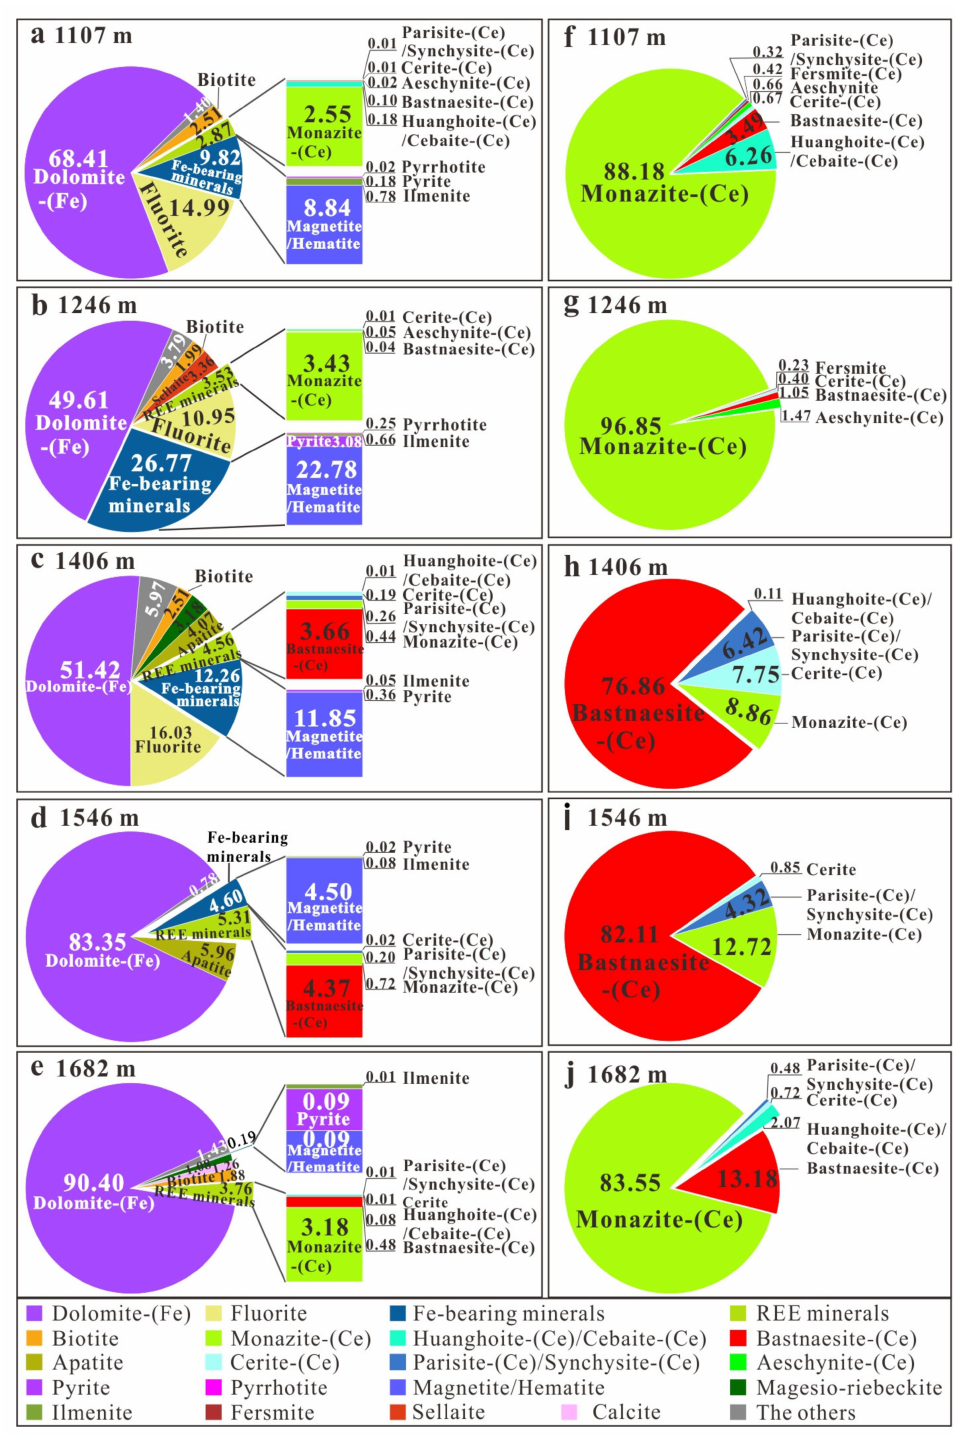
Figure 3. Mineral species and composition (left, in vol. %) and Ce elemental deportment (right, in wt. %) of different drill ore samples in the Eastern Orebody of Bayan Obo deposit. ( a ) mineral species and composition of sample 1107 m; ( b ) mineral species and composition of sample 1246 m; ( c ) mineral species and composition of sample 1406 m; ( d ) mineral species and composition of sample 1546 m; ( e ) mineral species and composition of sample 1682 m; ( f ) Ce elemental deportment at sample 1107 m; ( g ) Ce elemental deportment at sample 1246 m; ( h ) Ce elemental deportment at sample 1406 m; ( i ) Ce elemental deportment at sample 1546 m; ( j ) Ce elemental deportment at sample 1682